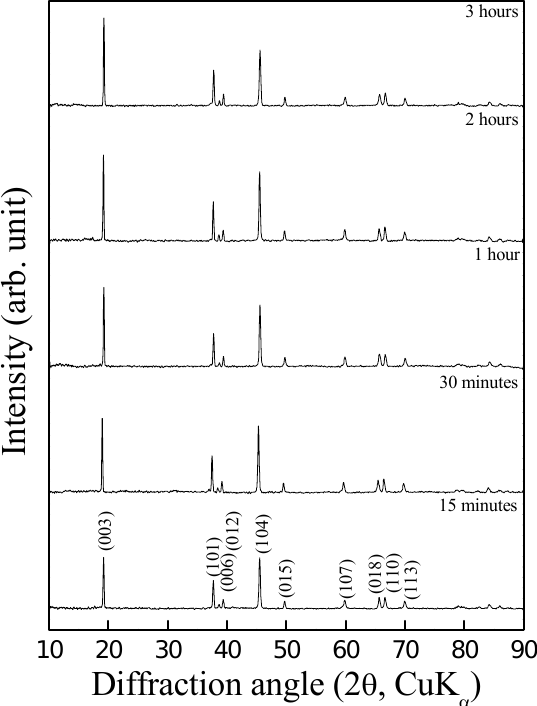
Figure 2. Powder X-ray diffraction patterns for LiCoO 2 obtained by heating nitrates at 700 ° C for varying durations.